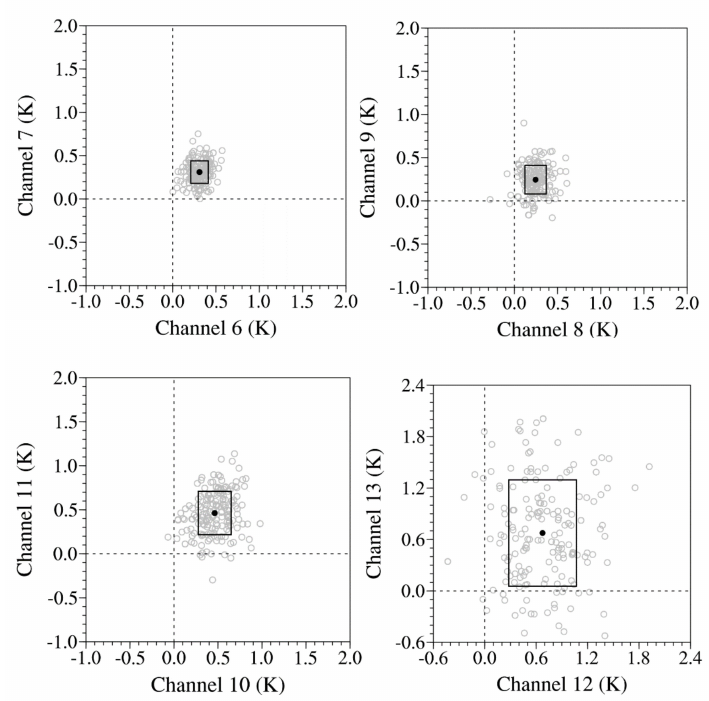
Figure 4. Scatter plots of double differences of brightness temperature observations for all FY-3D MWTS-2 channels having similar frequencies to NOAA-18 AMSU-A. The double difference bias (black solid dot) and one-standard deviation (black square) are also shown.